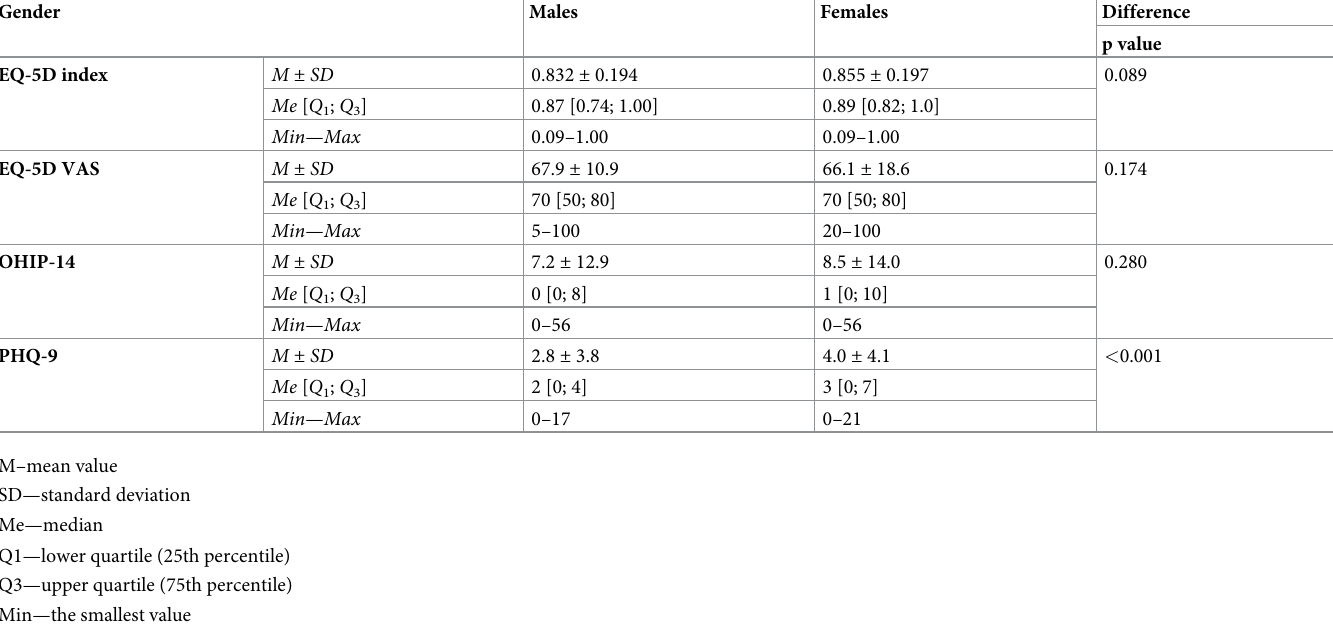
Table 5. Mean scores of